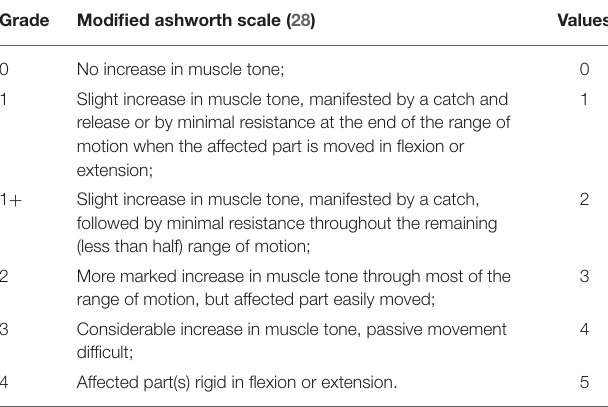
TABLE 1 | Definitions of MAS for grading muscle